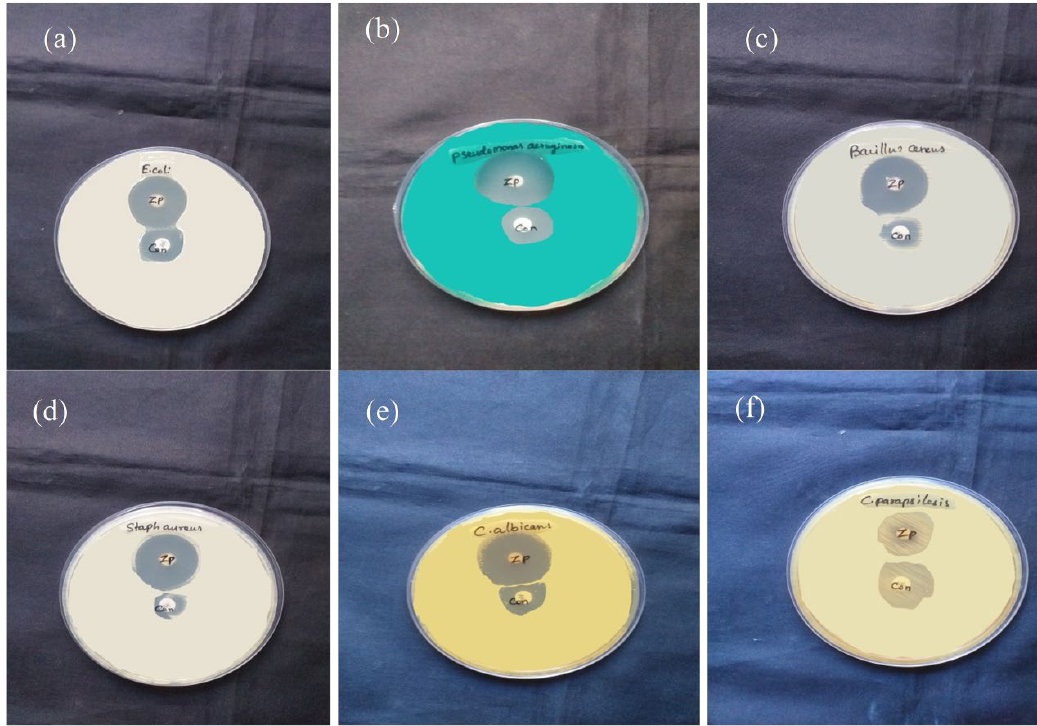
Fig. 13. Inhibition zones of bacterial and fungal strains